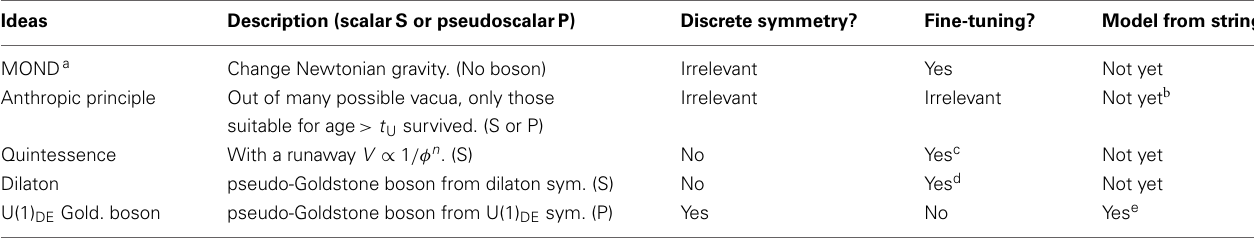
Table 1 | Typical DE models with a few pseudo-Goldstone bosons originating from global symmetries. Ideas